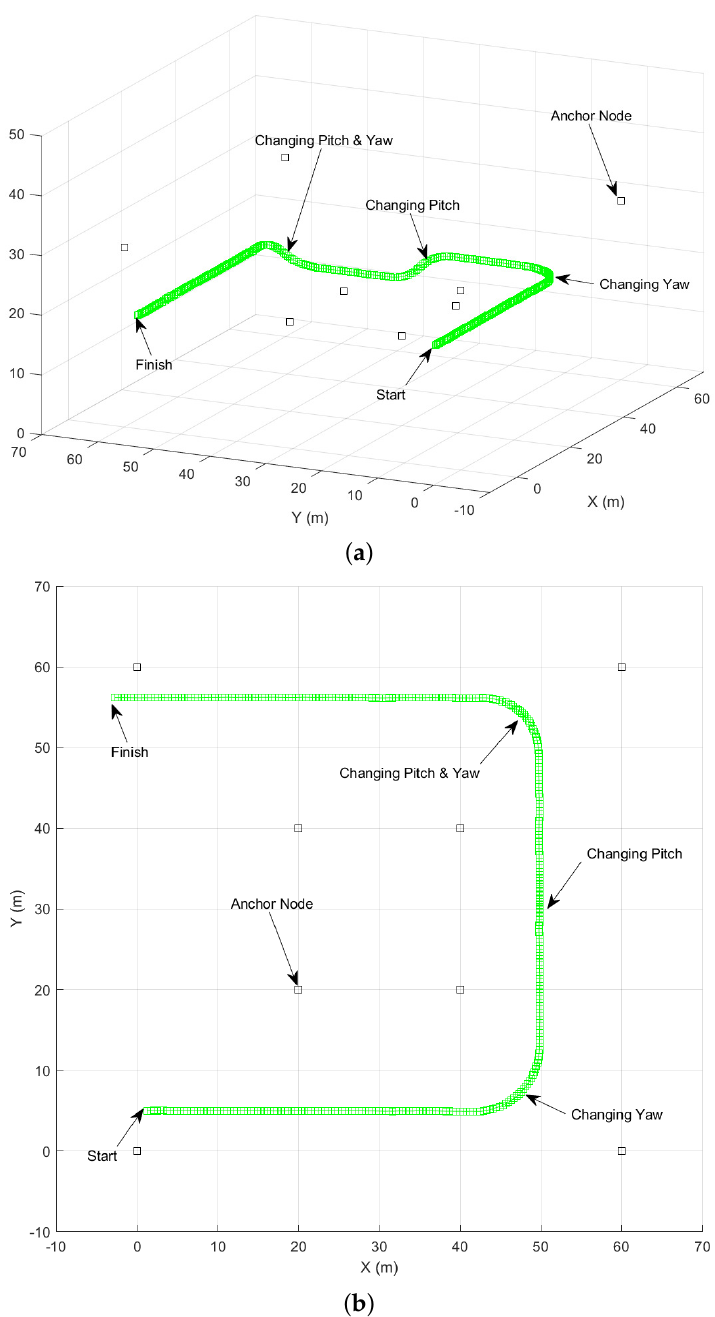
Figure 3. 3D localization scenario: ( a ) bird’s eye view ( b ) top